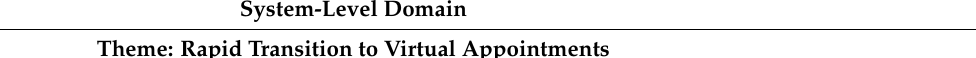
Table 2. Domains, Themes, and Representative Quotes from Providers on the Impact of the COVID-19 Pandemic on Mental Health Care Delivery in Pediatric Primary